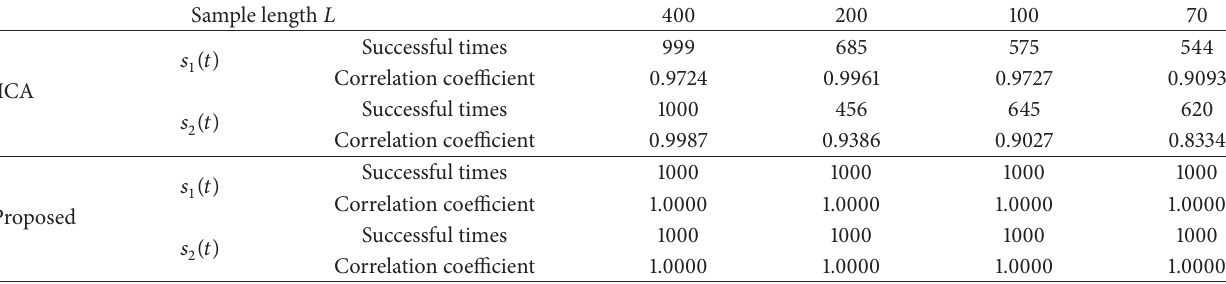
Table 1: The recovery correlation coefficients and successful times of numerical experiment.